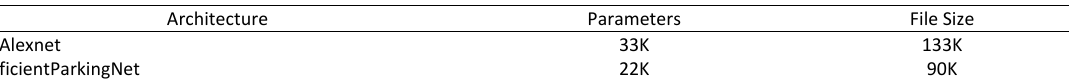
Table 10: Comparison of parameters and file size